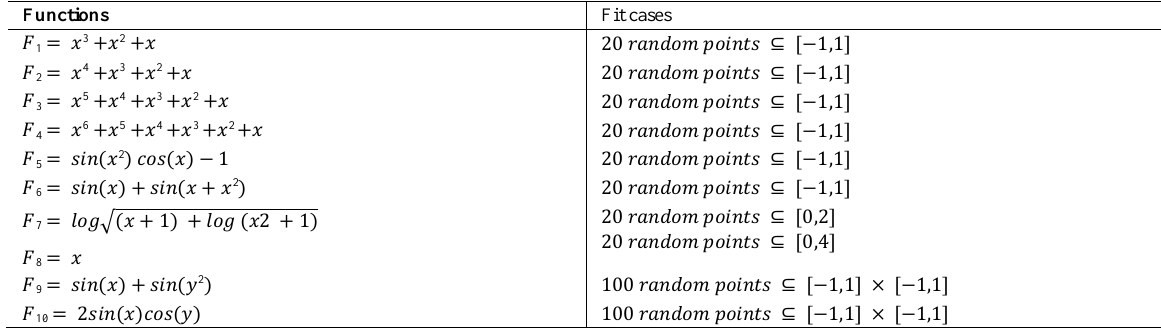
Table 1. Symbolic regression functions.